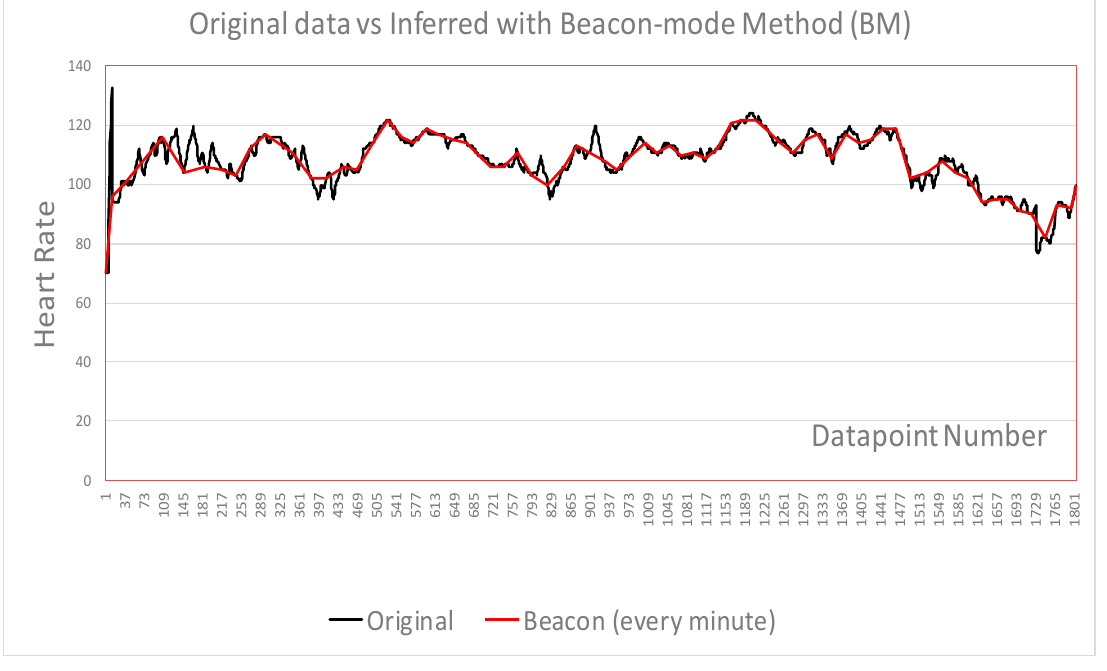
Figure 4. Original data points versus Beacon-mode method (BM) applied for inference (original DP: 1800, 70 beacons). Sensed data every second, and beacon sampled every minute.